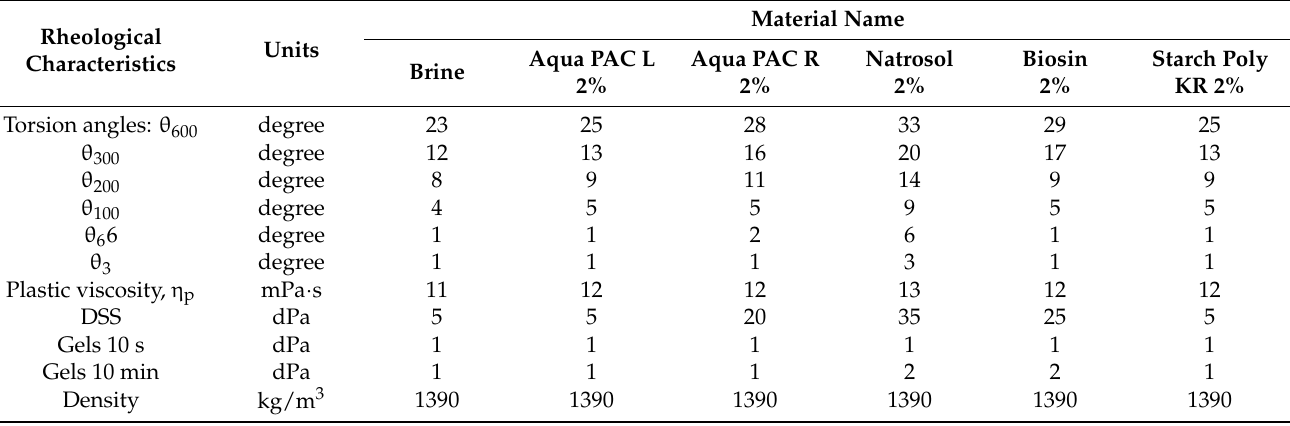
Table 2. Changes in the structural and rheological characteristics of brine during the processing of 2%